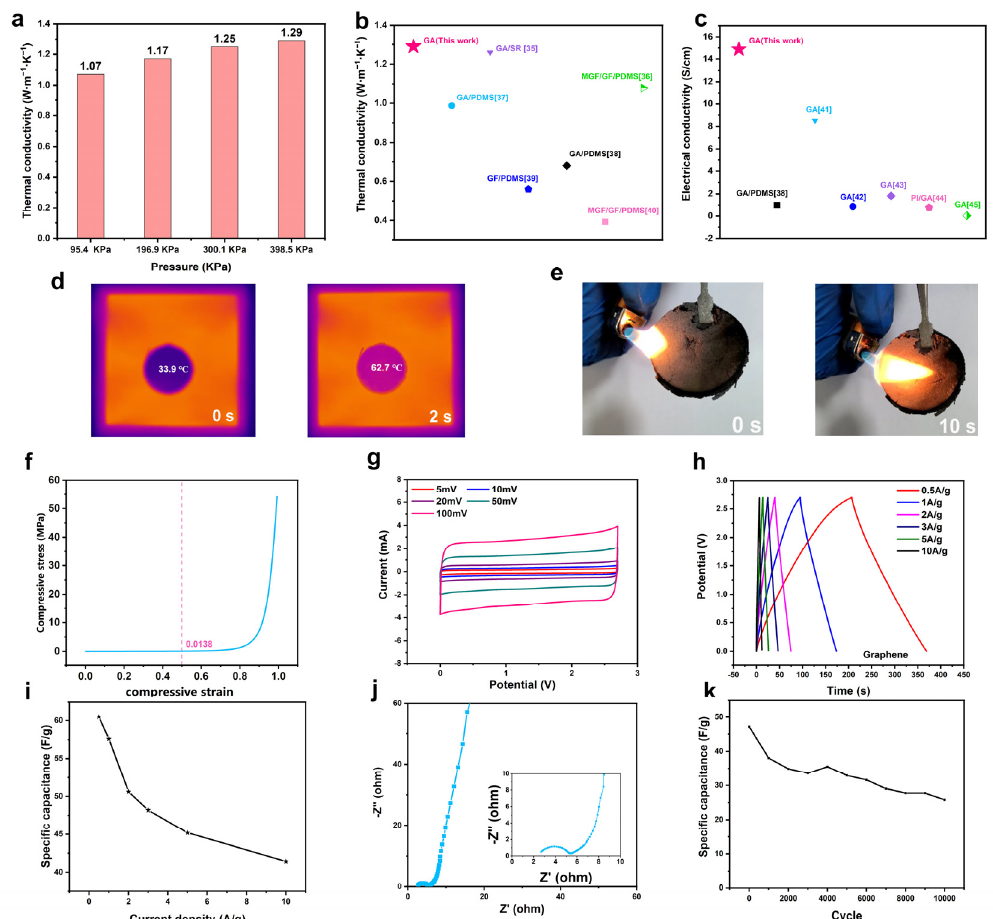
Figure 6. ( a ) Thermal conductivity of GA under different pressures, comparison of ( b ) thermal and ( c ) electrical conductivity of GA and other graphene-based materials in previous works [35–45]. ( d ) Infrared thermography images of GA heated for different times on a 100 °C hot stage, ( e ) fire resistance experiment of GA, ( f ) compressive of stress–strain of GA, ( g ) cyclic voltammetry curves with different scan rates, ( h ) galvanostatic charge/discharge curves with different current density, ( i ) capacitance retention with different currents density, ( j ) Nyquist plots, ( k ) cycling durability at 2.7 V.